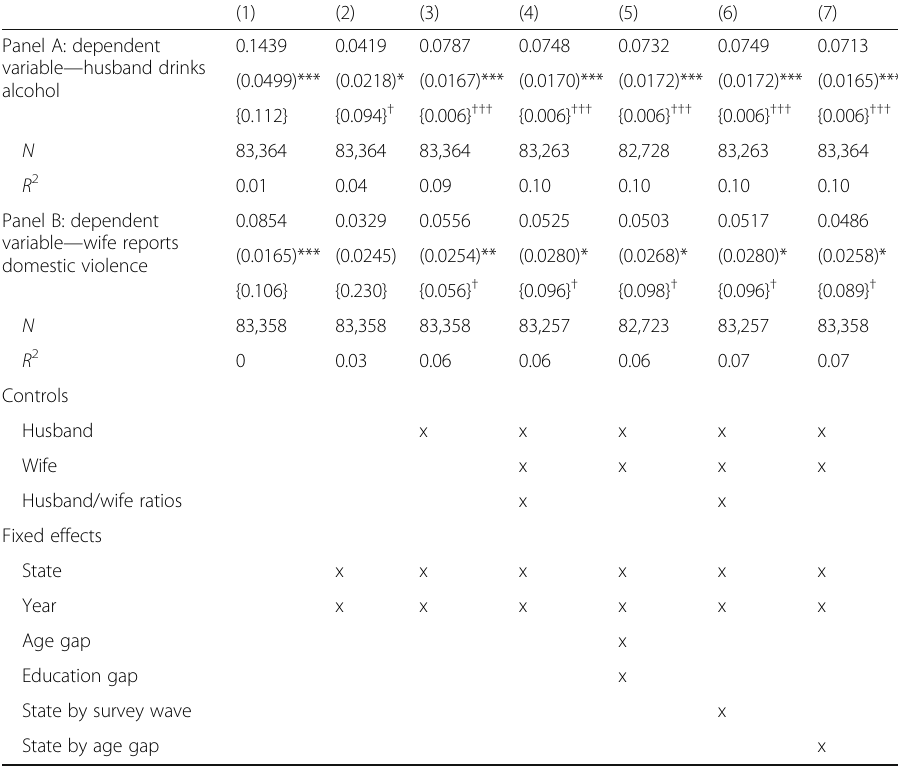
Sample includes husbands between ages 15 and 50 in the NFHS-2 and NFHS-3 waves. Controls for husband include age, years of schooling, whether he belongs to a white-collar occupation, household size, urban residence, religion, and number of children. Controls for wife also include these variables plus, her attitudes towards domestic violence, whether she has money of her own that she controls, and the wife to husband age and schooling ratios. Standard errors presented in parentheses are clustered by state. *Significant at 10%, **significant at 5%, ***significant at 1%. p values in braces are adjusted using wild- t bootstrap. † p ≤ 0.1, †† p ≤ 0.05, ††† p ≤